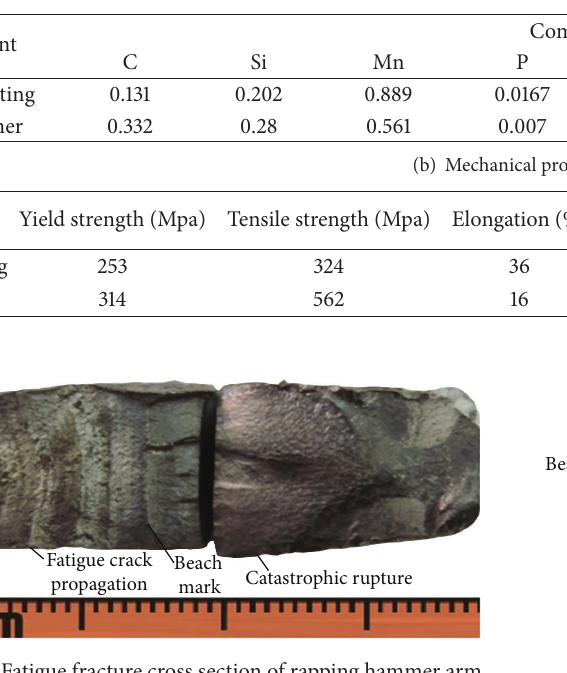
Figure 6: Fatigue fracture cross section of rapping hammer arm.